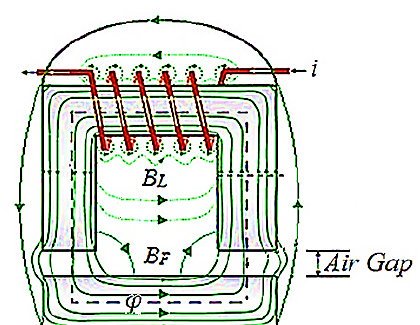
Figure 1: Electromagnet with U_I structure